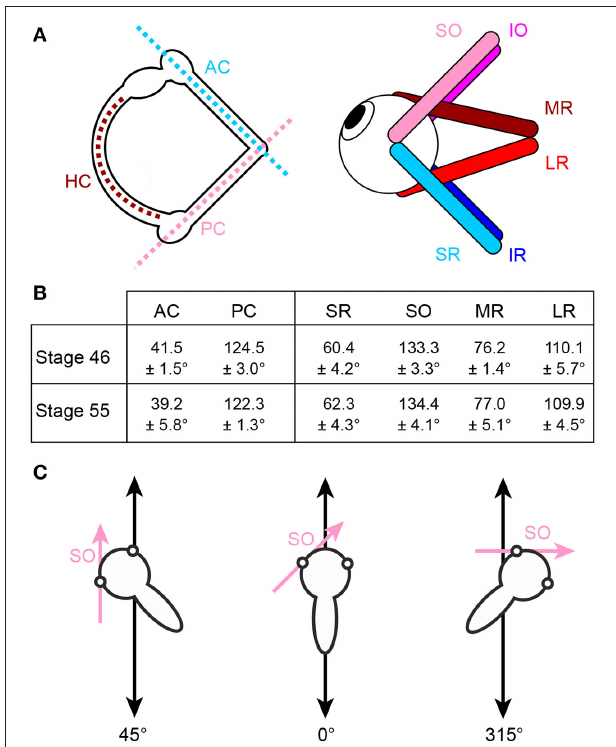
FIGURE 1 | Arrangement of eye muscle pulling directions and semicircular canal planes. (A) Schematics depicting the spatial alignment of the three semicircular canals (left) and the six extraocular muscles (right) of the left inner ear and eye, respectively; note that color-coded antagonistic pairs of eye muscles are approximately aligned with individual semicircular canals. (B) Mean orientation of vertical semicircular canals and eye muscle pulling directions ( ± SEM) relative to the body length axis in tadpoles at developmental stage 46 and 55 (from n = 5 animals, respectively). (C) Exemplary orientations of semi-intact tadpole preparations either longitudinally on the linear sled (0 ◦ , middle) or in positions in which the SO eye muscle (magenta arrow) was either oriented parallel (left, 45 ◦ ) or perpendicular (right, 315 ◦ ) to the translational motion direction (double-headed black arrow). HC horizontal semicircular canal; AC, PC anterior, posterior vertical semicircular canal; IO, IR, inferior oblique, rectus muscle; LR, MR, lateral, medial rectus muscle; SO, SR, superior oblique, rectus